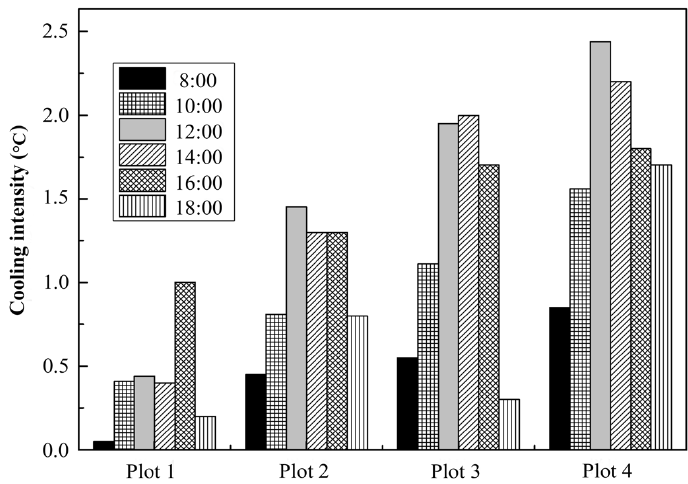
Figure 4. Comparison of different cooling effects between 8 o’clock and 18 o’clock.